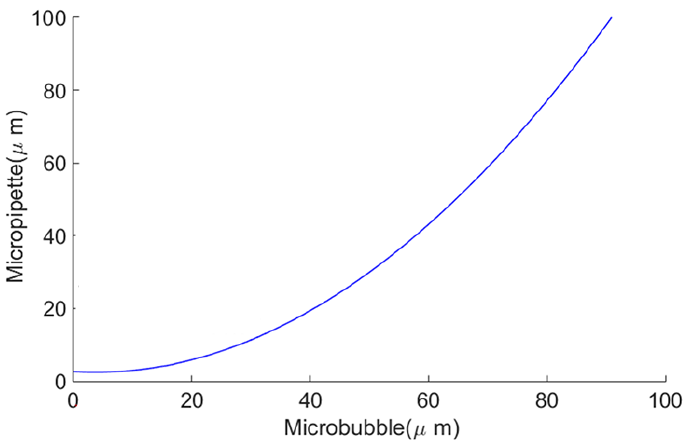
Figure 11. Estimation curve of the micropipette internal diameter as a function of the microbubble diameter.